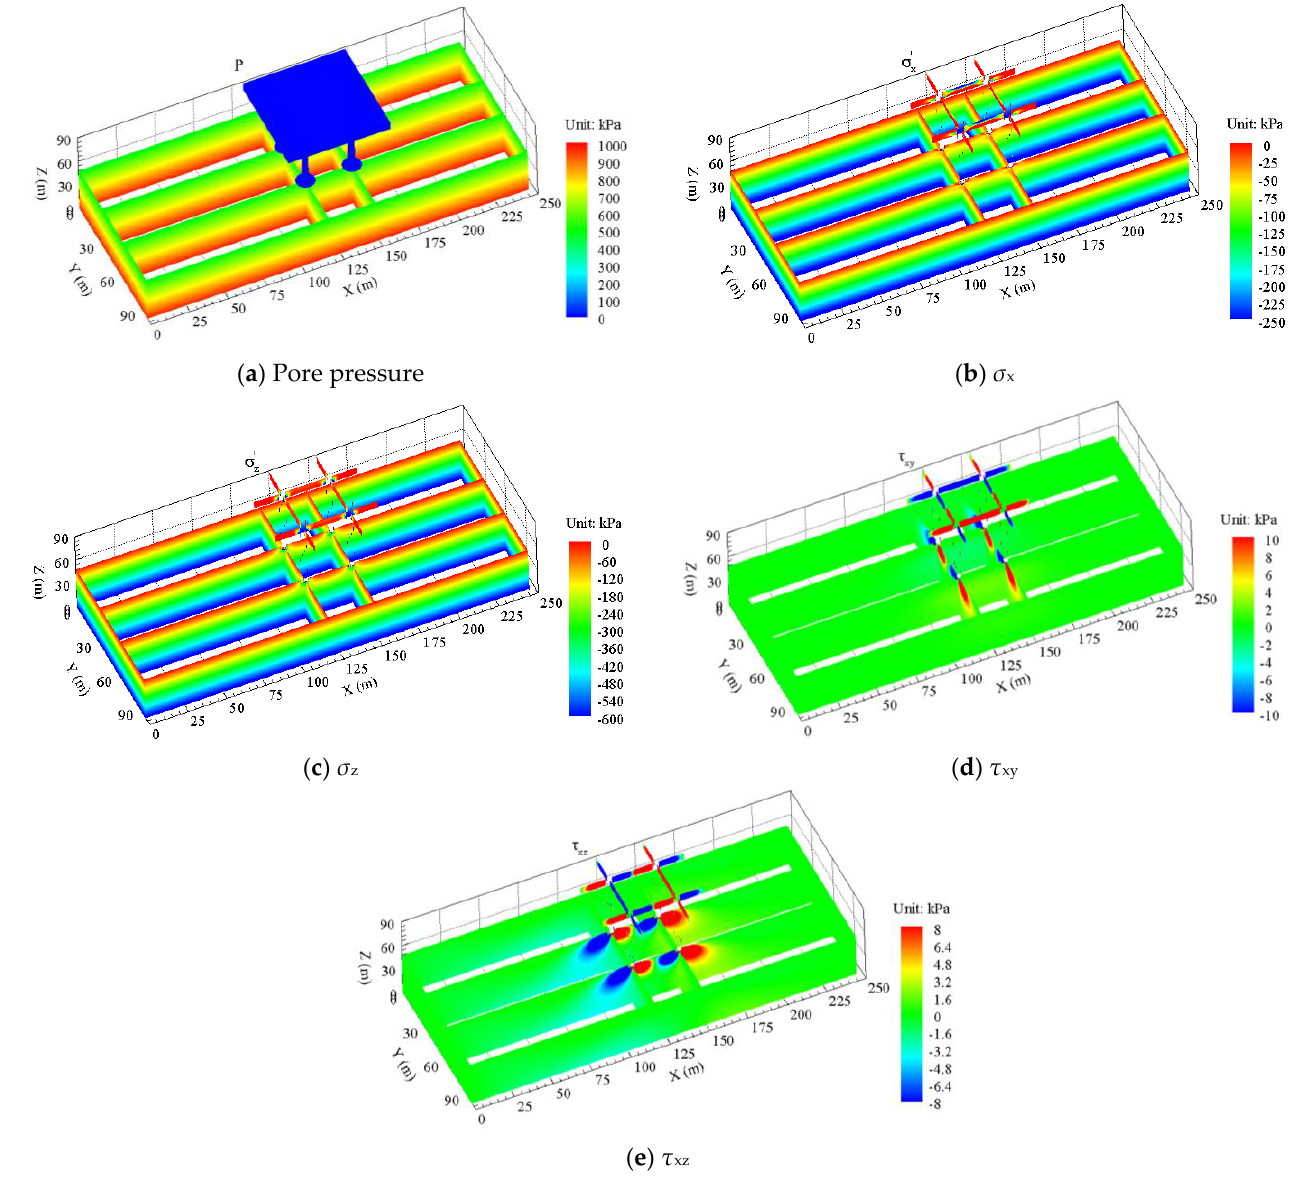
Figure 11. Distribution of pore pressure, effective stress, and shear stress in the offshore platform and its seabed foundation in the initial equilibrium state.